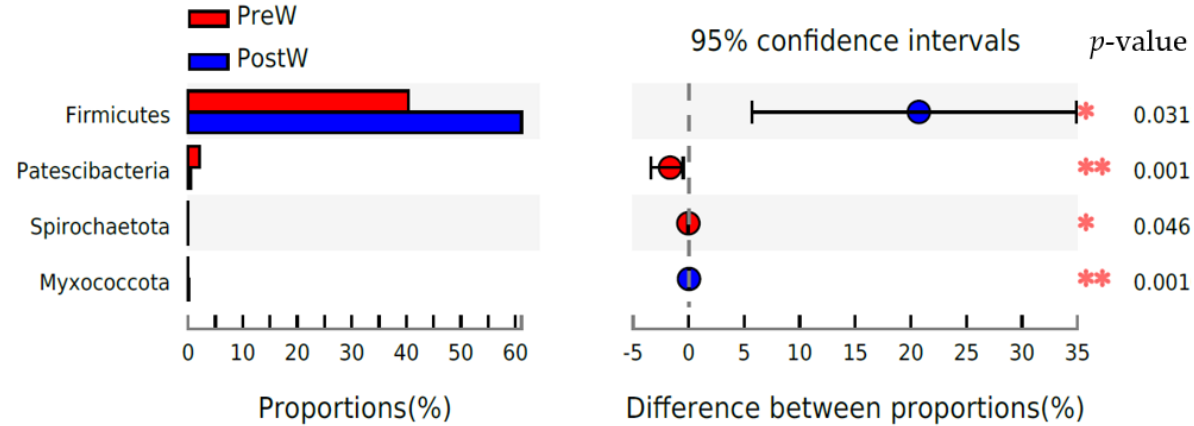
Figure 4. Difference in the predominant oral bacteria at phylum level between preweaning and postweaning donkeys (abundance of the phylum is expressed as %). Extended error bar plot was created by bioinformatics software (STAMP). Welch’s two - sided test was used and Welch’s inverted was 0.95; PreW, preweaning group; PostW, postweaning group. *, p < 0.05; **, p < 0.01. At the genus level (Figure 5), the six predominant genera were Gemella (15.8~33.5%), Streptococcus (12.3~14.3%), Alysiella (2.7~11.7%), Actinobacillus (3.4~9.9%), Moraxella (1.2~9.2%), and Neisseria (4.6~4.7%).